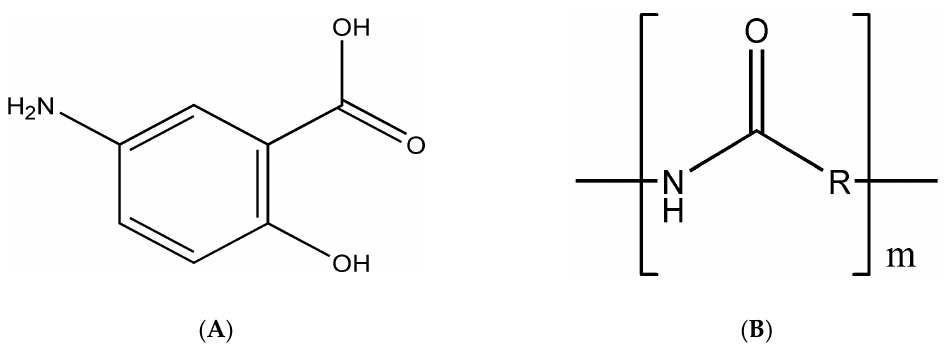
Figure 1. Chemical structure of mesalazine ( A ) and zein ( B ).